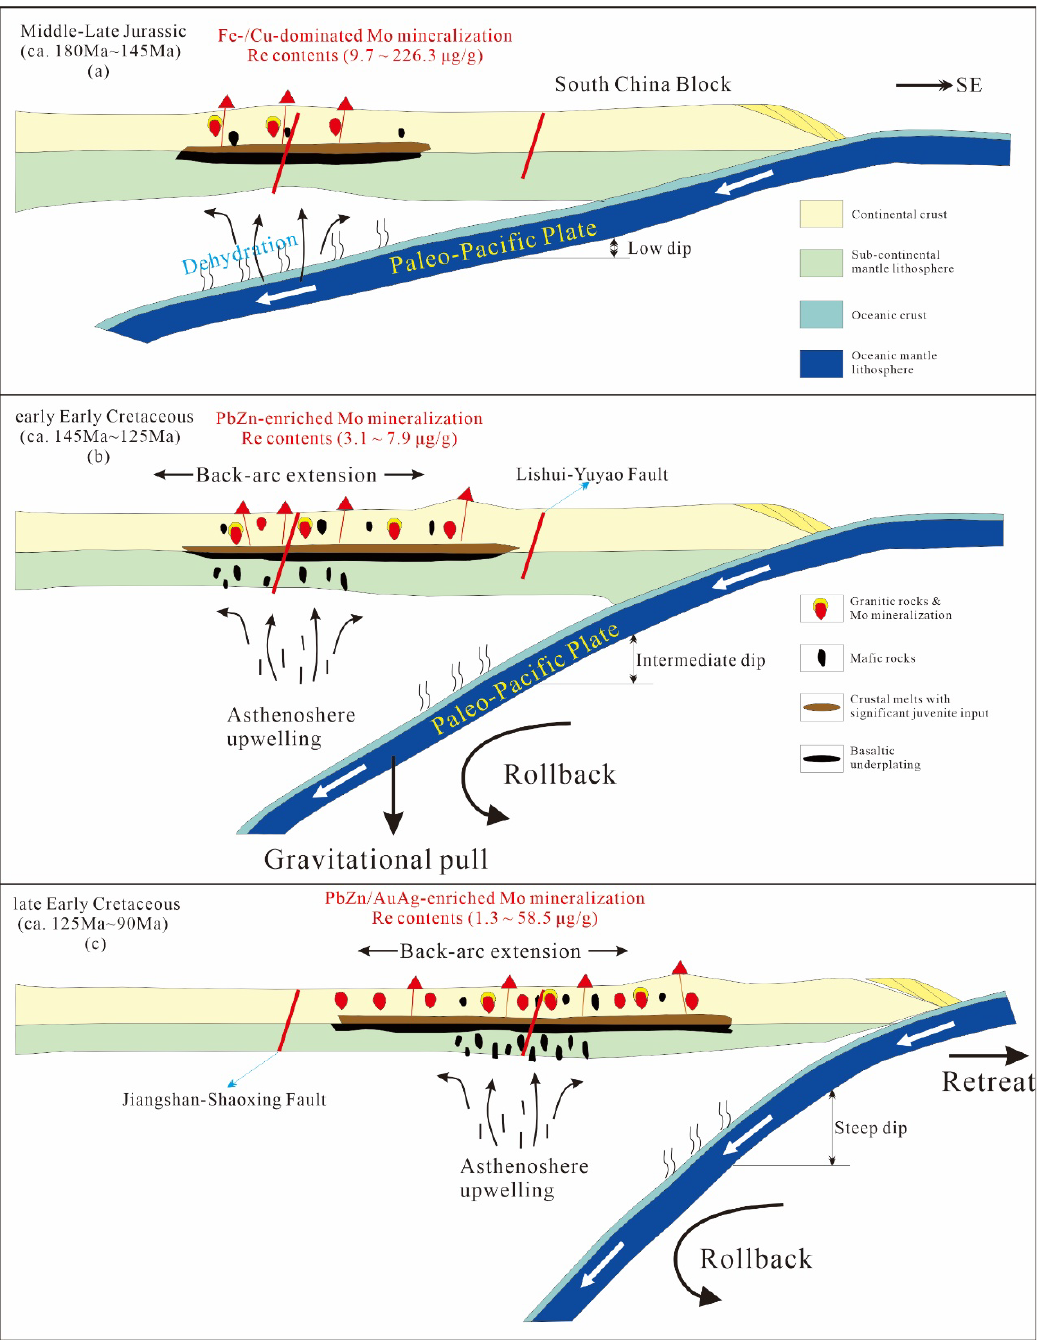
Figure 9. The tectono-magmatic-mineralization evolution model of the Paleo-Pacific plate subduction in Zhejiang Province in the SCMP during the Late Mesozoic. ( a ) the low-dipping-angle subduction of the Paleo-Pacific plate in the Stage I (170–145 Ma); ( b ) the rollback beginning of the Paleo-Pacific plate in the Stage II (145–125 Ma); ( c ) the progressive rollback and retreat of the Paleo-Pacific plate in the Stage III (125–90 Ma). Modified from Wang et al., 2018 [24].